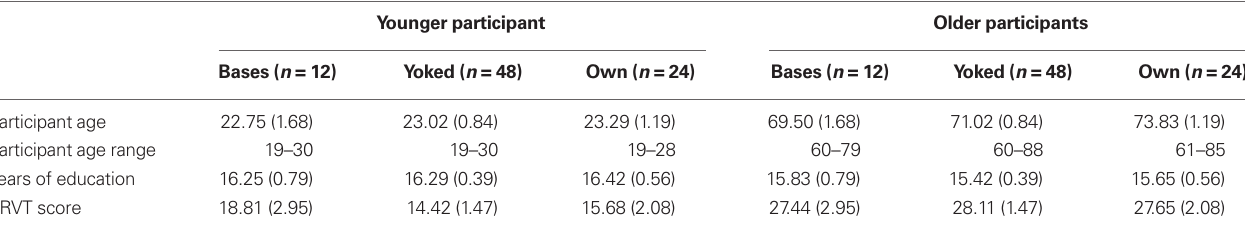
Table 1 | Participant age ranges, mean (SE) age, years of education, and ERVT scores for younger and older participants across the different viewing